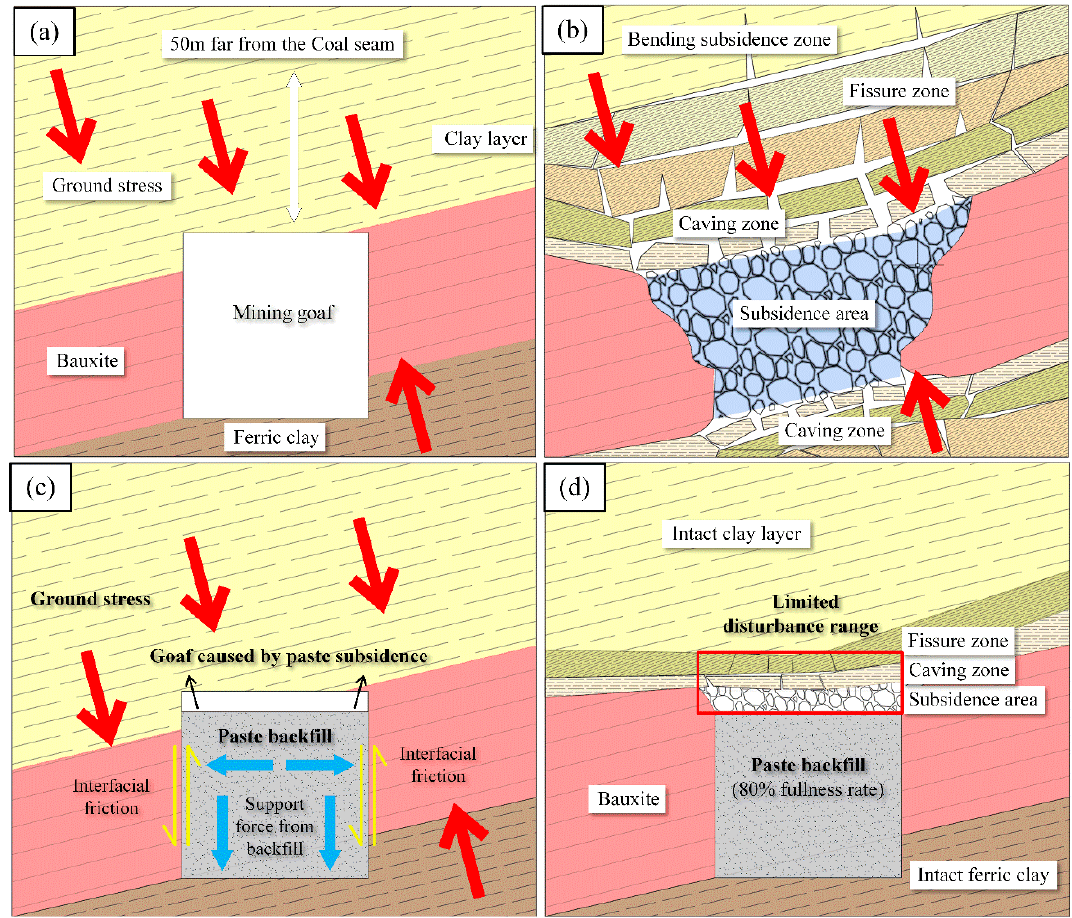
Figure 11. Failure process of layered soft rocks and mechanism analysis of paste backfill: ( a ) goaf after mining; ( b ) collapsed goaf; ( c ) goaf after paste backfill ( d ) stable goaf.